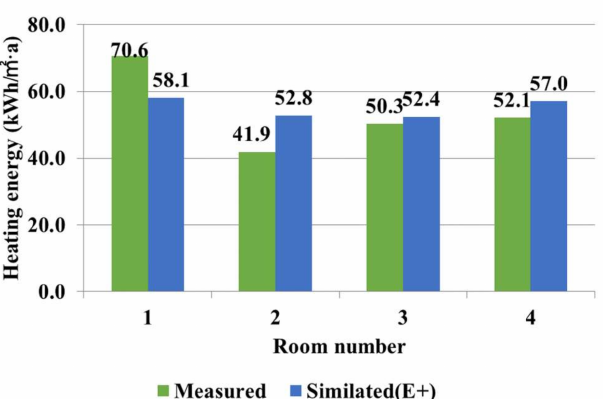
Figure 16. Comparison between the measured average heating energy consumption and the Energy- Plus simulation.